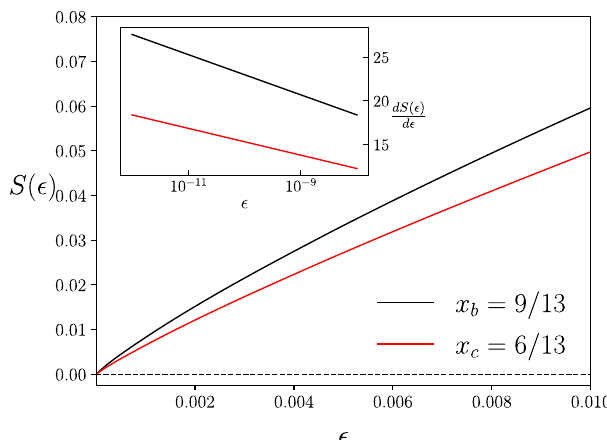
Fig. 1 Behaviour of the von-Neumann entropy in the vicinity of an ϵ log-singularity. Two density operators ρ b ( ϵ ) and ρ c ( ϵ ) with spectrum (1 − x b ϵ , x b ϵ ) and (1 − x c ϵ , x c ϵ /3, x c ϵ /3, x c ϵ /3) respectively have entropies S b ( ϵ ) and S c ( ϵ ) respectively, where 0 ≤ ϵ ≤ 1. For fi xed ϵ log-singularity rates x b = 9/13 and x c = 6/13, of S b ( ϵ ) and S c ( ϵ ), respectively, a plot of these entropies S ( ϵ ) as a function of ϵ . The inset shows the gradient of the entropies as a function of log 2 ϵ for small ϵ .